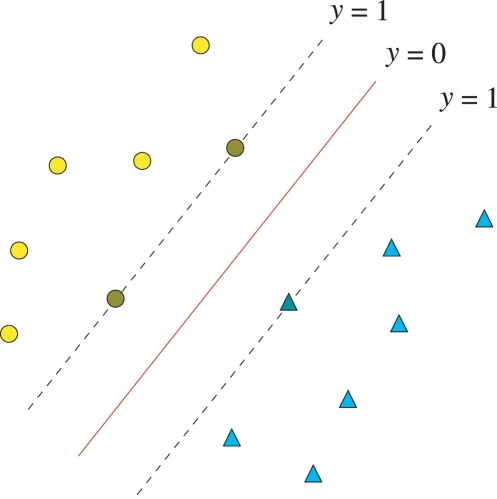
Maximum margin hyperplane used in support vector machines.Example showing the hyperplane with maximal margin of separation between samples from two different haplogroups. The shaded points lying on the margin define the support vectors.